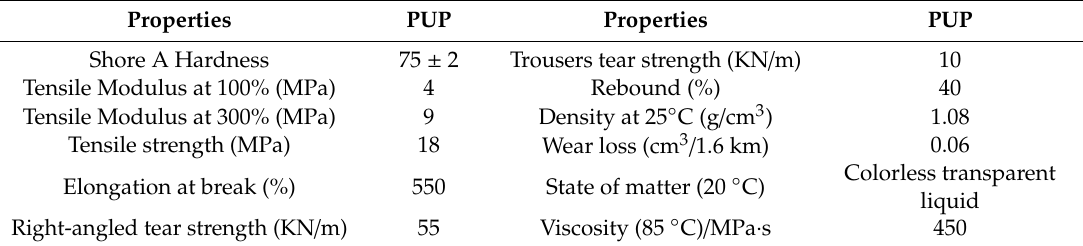
Table 3. Properties of